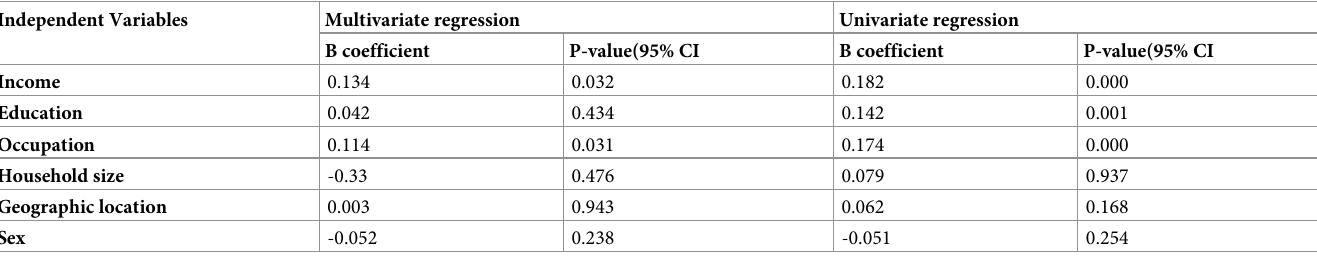
Table 6. Result of linear multivariate regression